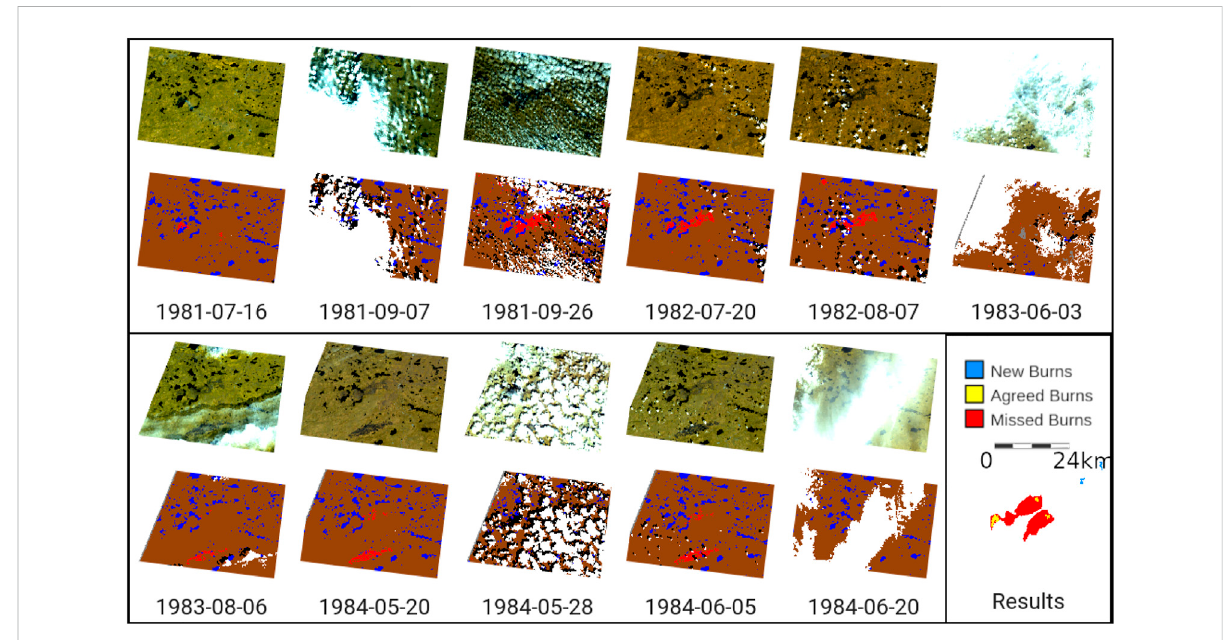
FIGURE 12 ResultsDetailJ.EveryusableMSSimageandUNetclassi fi cationofa fi rethatstarted1981 – 07-13accordingtotheCNFDBbutwasnotdetected by our methodology.